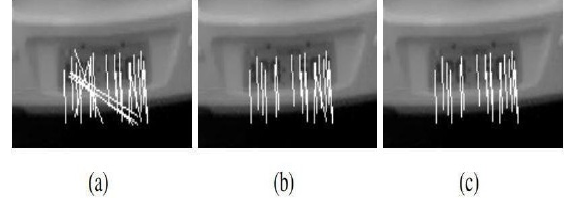
Fig. 9: Outlier Rejection: a) Motion Vectors